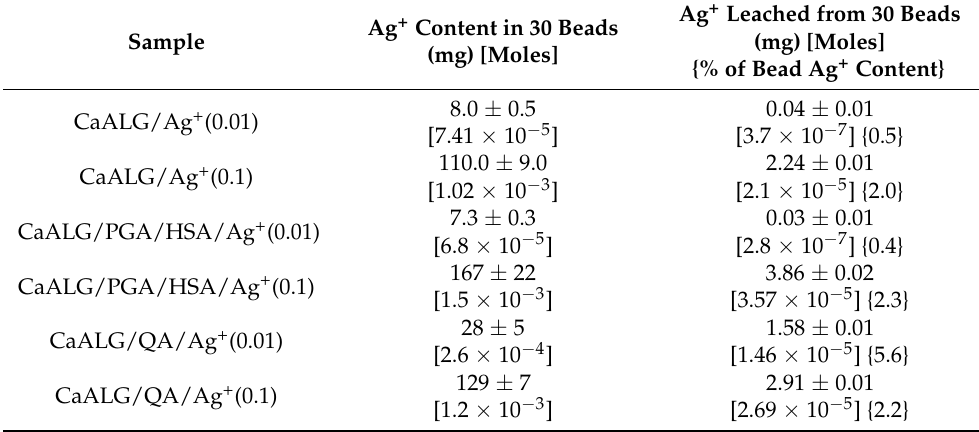
Table 2. Uptake and release of Ag + ions for Ag + -containing